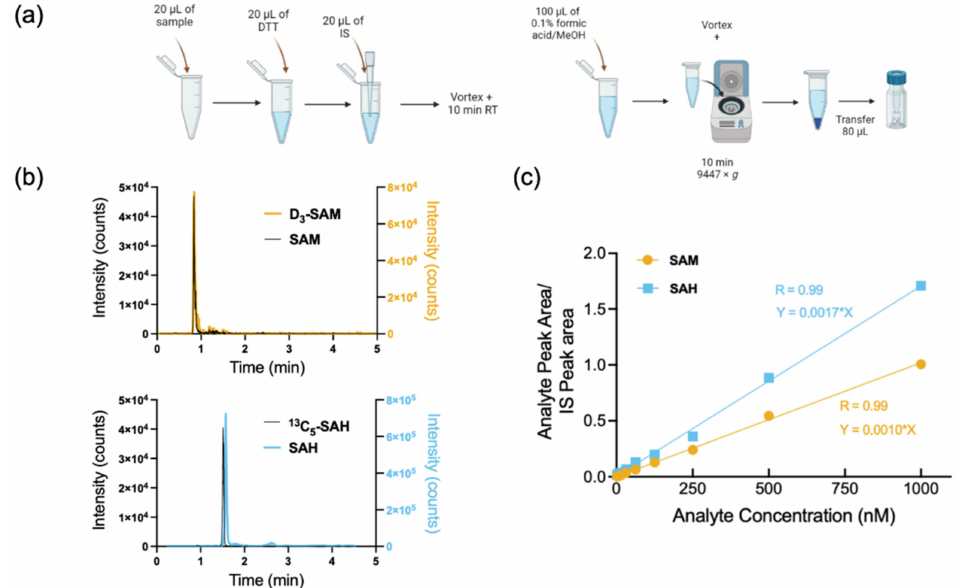
Figure 2. Overview of sample preparation, chromatographic separation, and the linearity of SAM and SAH calibration curves. ( a ) Sample preparation scheme showing 20 µ L of starting material (plasma, urine, conditioned culture medium, or cell lysate) extracted into a total volume of 160 µ L, followed by centrifugation to spin down proteins and other precipitated biomolecules and transfer of the supernatant into an HPLC vial. ( b ) Chromatograms of SAM and SAH and their respective stable